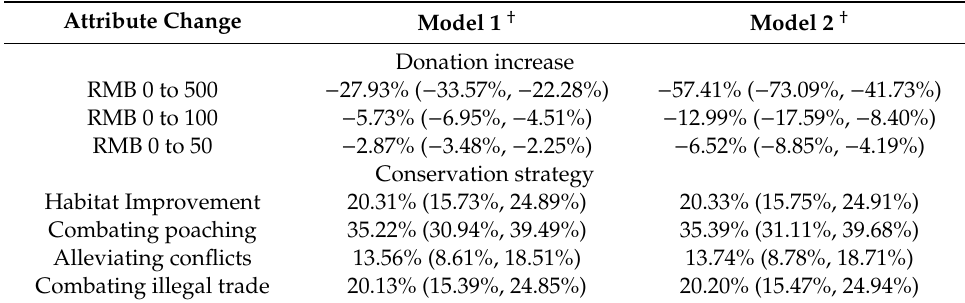
Table 6. Simulated uptake rates for changes in the funding and strategy attribute